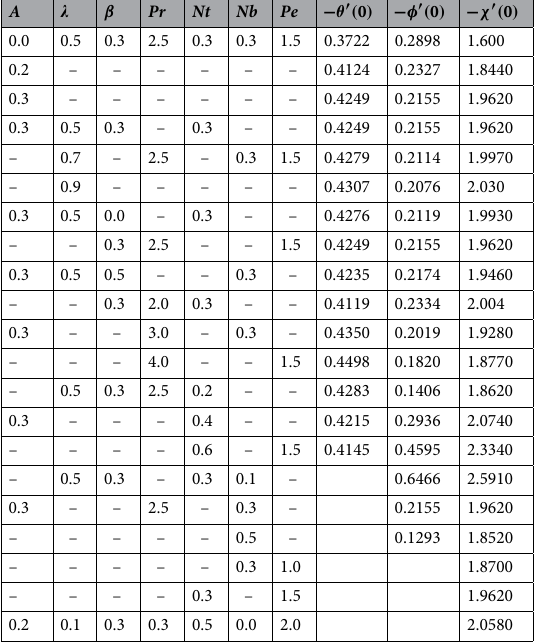
0.5 for different parameters when γ = ε =